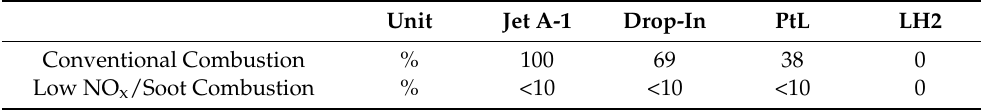
Table 2. Relative soot number reduction potentials.